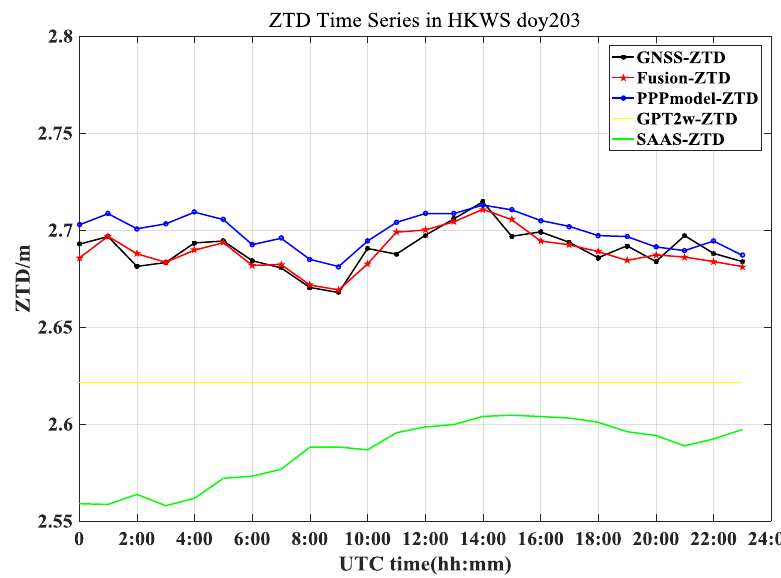
Figure 4. GNSS-derived and estimated ZTD by kinds of models at station HKWS on DOY203. For the active troposphere period assessed, time series of the mean differences and of the corresponding standard deviations over the network are presented in Figure 5 for different troposphere models.